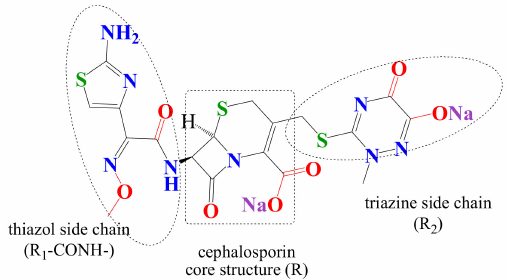
Figure 7. Molecular structure of ceftriaxone